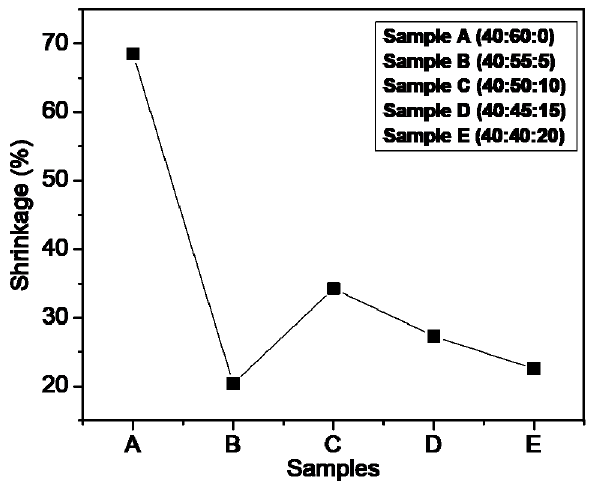
Figure 6. The shrinkage percentage of the scaffold.